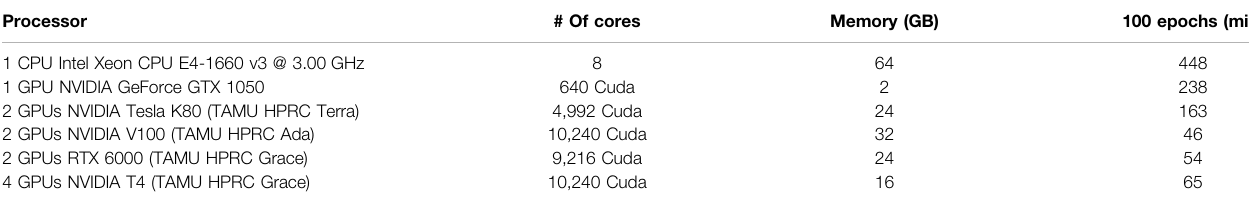
TABLE 3 | Proposition 3 training time comparison for different hardware (CPUs and GPUs). Processor # Of